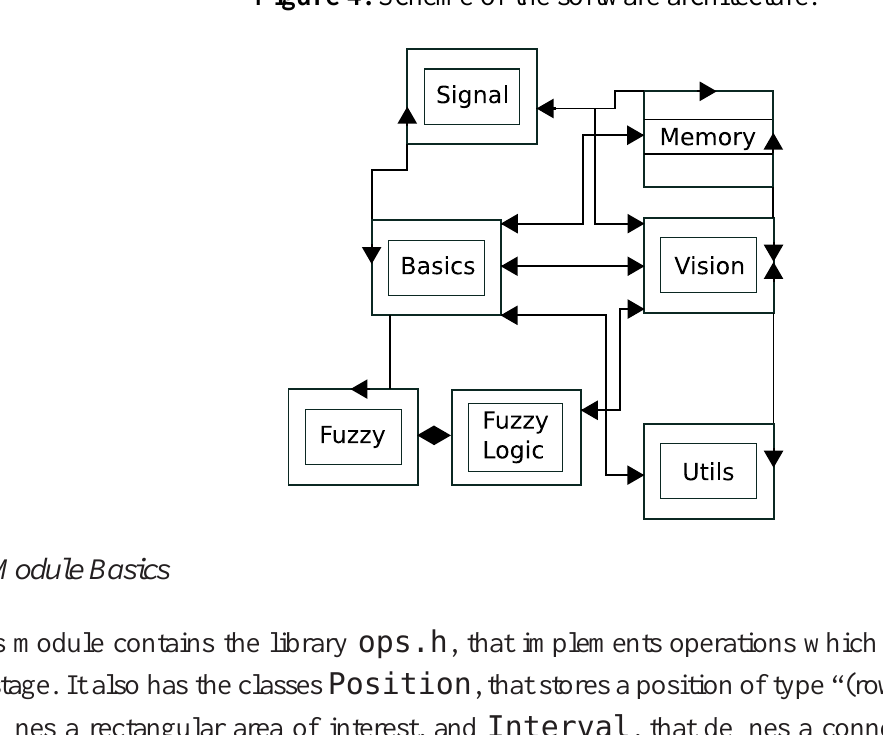
Figure 4. Scheme of the software